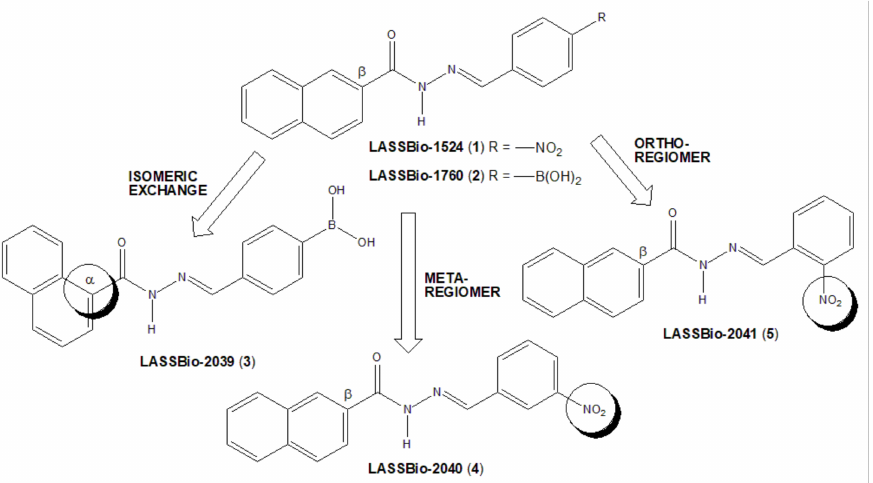
Figure 1. Design concept of novel naphthyl- N -acylhydrazone derivatives ( 3–5